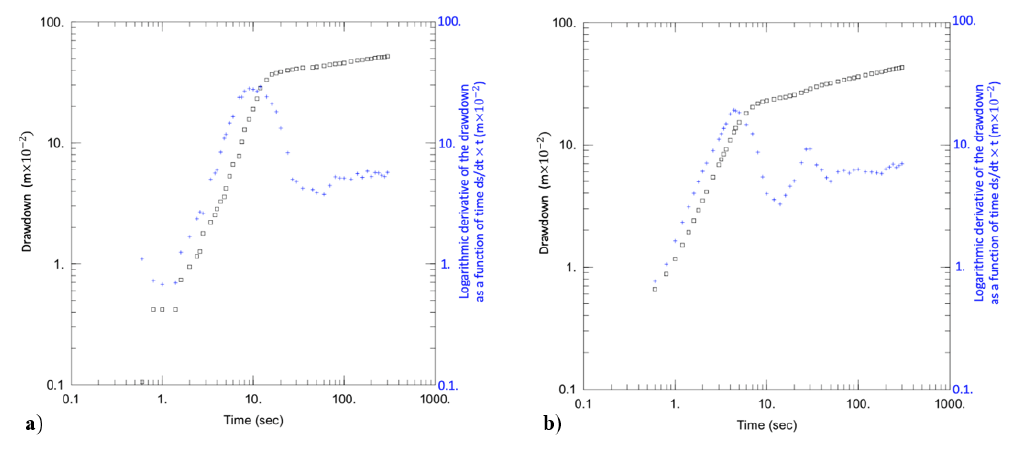
Figure 8. Illustration of the numerical model setup. The cylinder on the left is the wellbore. The hollow cylinder outside the wellbore represents the well skin. The blue planes represent the fractures within the matrix.